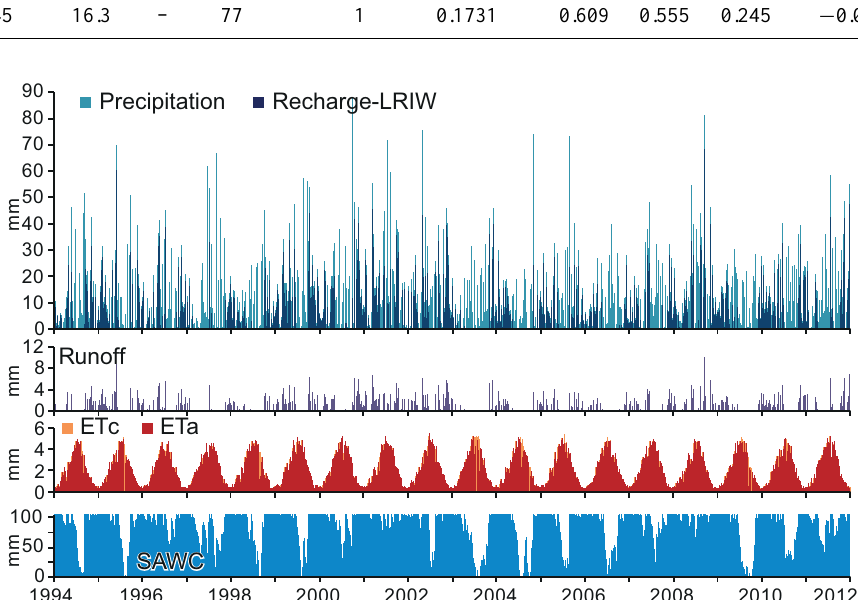
Figure 8. Recharge computation with the LRIW method at Séchilienne with an SAWC of 105mm and a runoff coefficient of 12.8%. ET c : specific vegetation evapotranspiration; ET a : actual vegetation evapotranspiration, SAWC: soil available water capacity.